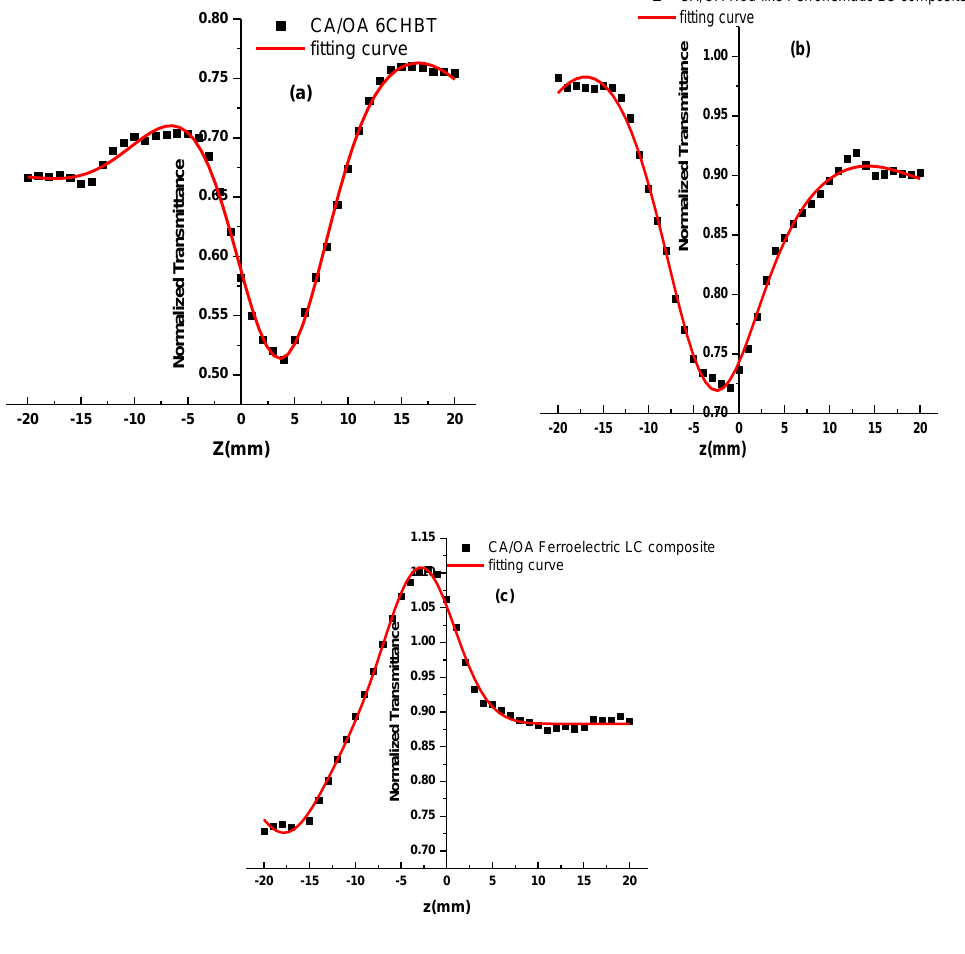
Fig.6: The nonlinear refractive index (CA/OA) case, (a) 6CHBT, (b) Rod-like Ferronematic LC composite, and (c) Ferroelectric LC composite. Table 3: The nonlinear refractive index of the submitted samples in case of division CA over